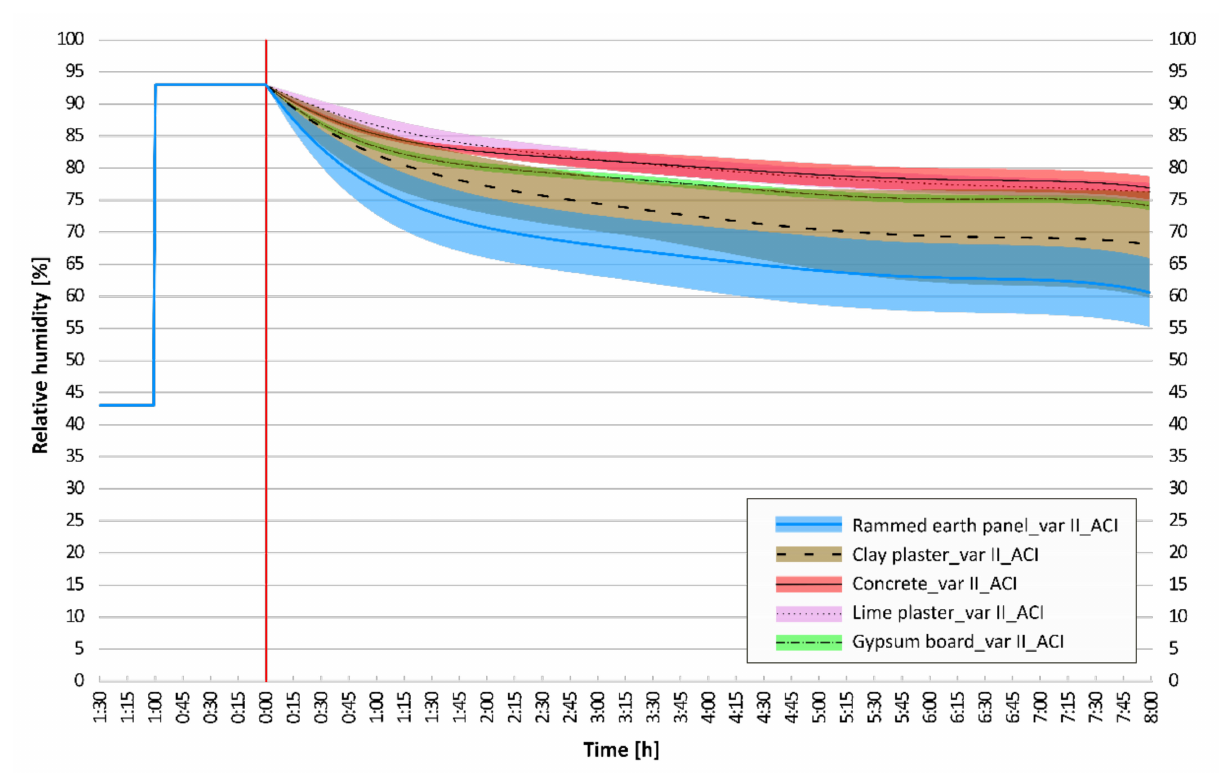
Figure 11. Comparison of adjusted confidence intervals: rammed earth panel, concrete, lime plaster, gypsum board.